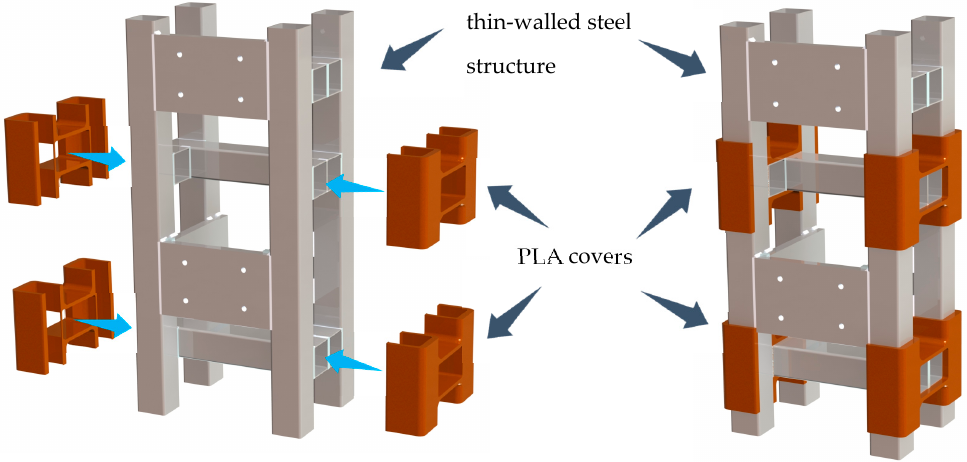
Figure 1. Concept of additively manufactured eliminators.